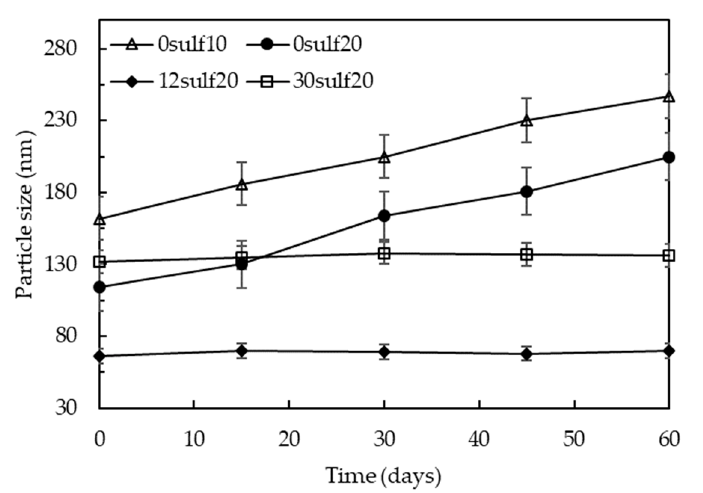
Figure 14. Influence of sulfonate groups on nanoparticles stabilization.